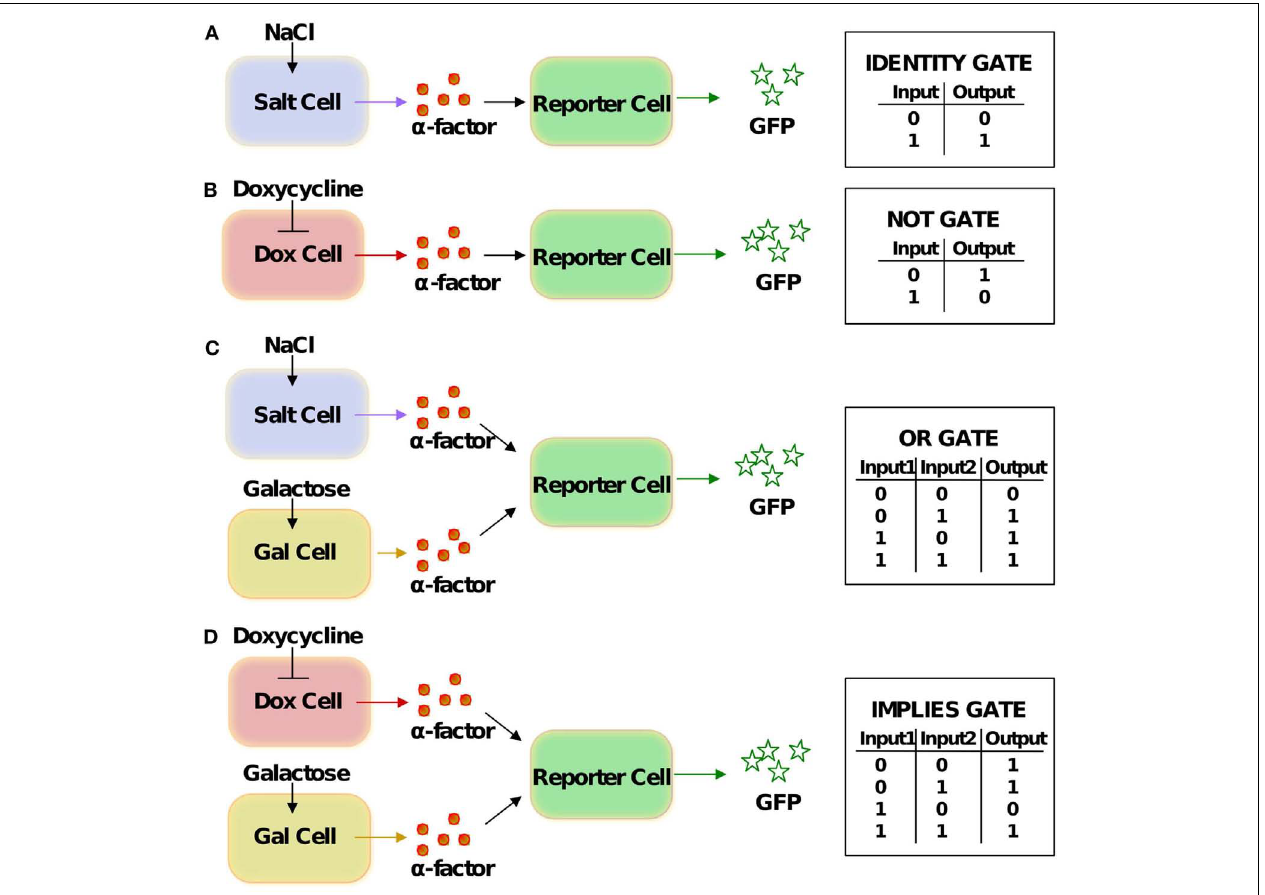
(Regot et al., 2011): if glucose instead of galactose is viewed as one of the inputs for the gates in (C,D) , they perform the IMPLIES and NAND functions,